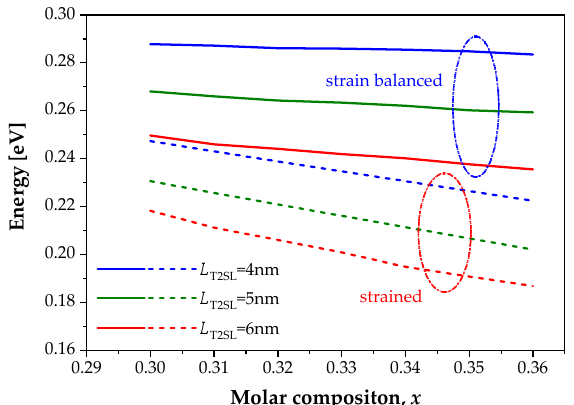
Figure 5. Theoretical simulation of the bandgap energy versus the Sb molar composition, x for the layer thickness T2SL L T2SL = 4 nm, L T2SL = 5 nm and L T2SL = 6 nm.